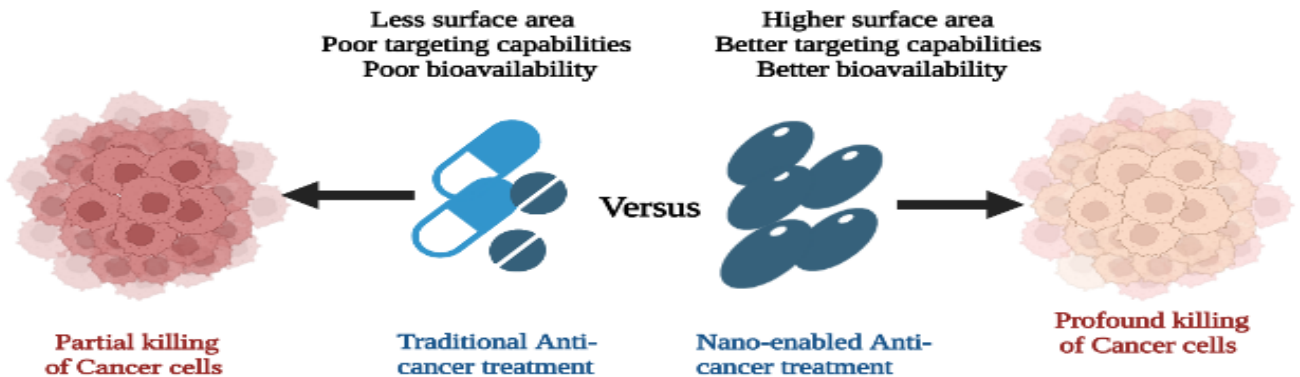
Figure 1. Comparison of traditional and nano-based methods of cancer treatment.